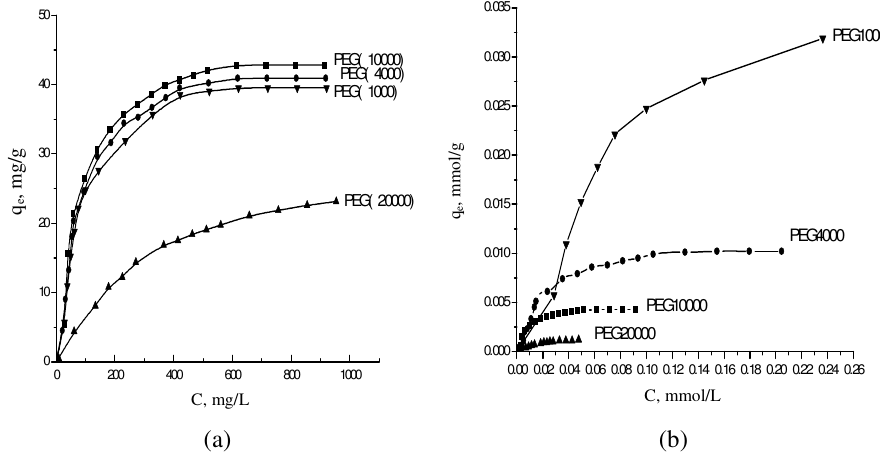
Figure 1. Adsorption isotherm of PEG (1000, 4000, 10000, 20000) at 25 o C, (a) Adsorbance is defined as mg/g; (b) Adsorbance is defined as